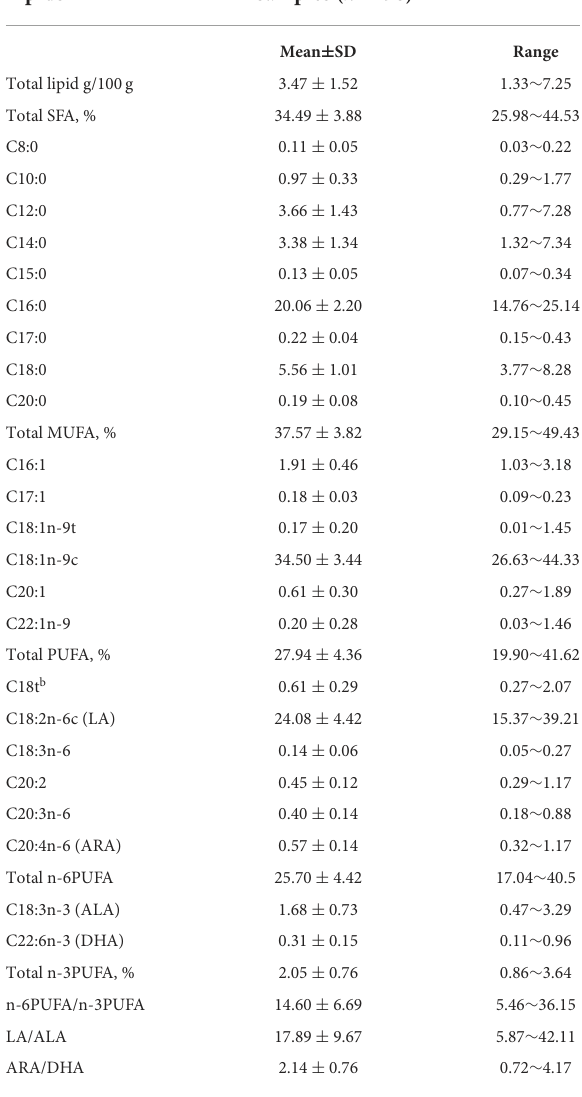
TABLE 2 Total lipid content (g/100g milk) and fatty acid (% total fatty acids) levels in mature milk a . Lipids All samples ( n =